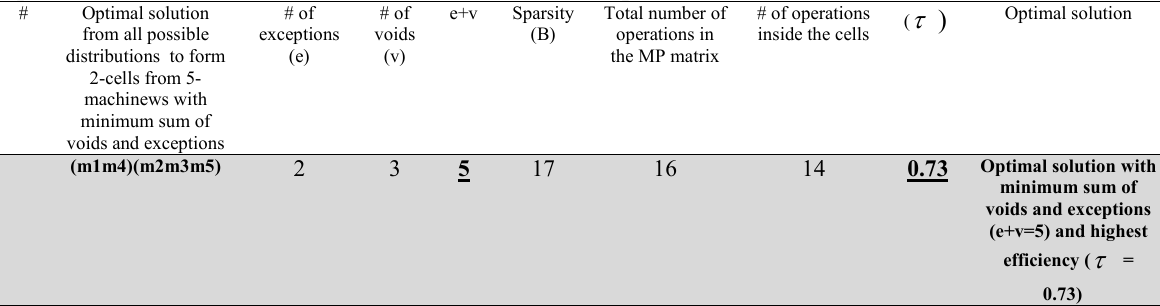
Fig. 8. Second optimal 2-cell solution with minimum voids and highest efficiency From Table 5, it is clear that there is one optimal solution with (e+ v=5) and the efficiency of the system is 0.73. The optimal solution is shown in Fig. 9. Optimal solution with minimum sum of voids and